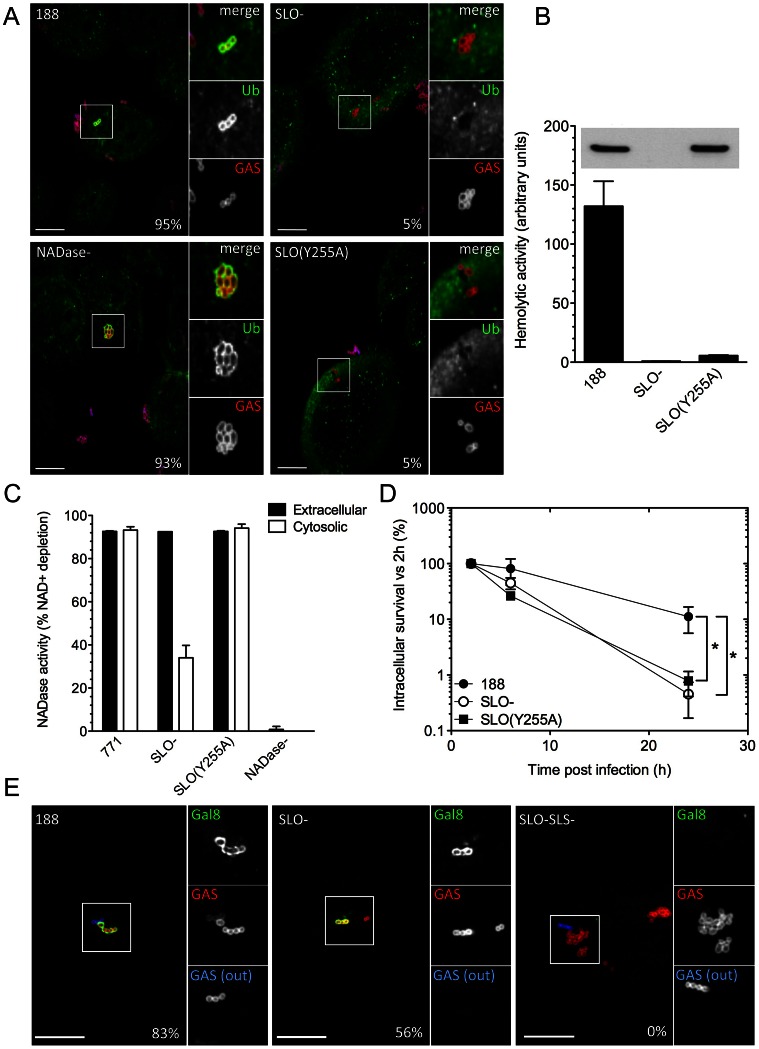
SLO, SLS, and NADase affect xenophagy and GAS intracellular survival.
A. Confocal microscopy demonstrating the association between ubiquitin (green) and intracellular GAS (red) at 30 min post-infection in keratinocytes infected with GAS strain 188, 188SLO-, 188NADase-, or 188SLO(Y255A). Extracellular GAS were stained blue and red for identification as described in Figure 2. Scale bar = 10 µm. The percentage of intracellular GAS that were associated with ubiquitin is indicated for each strain, based on quantification of at least 100 bacteria in three independent experiments. B. Hemolytic activity of culture supernatants of GAS strain 188, 188SLO-, and 188SLO(Y255A). The amino acid substitution Y255A in SLO abrogates the ability of SLO to porate the host cell membrane, demonstrated by the failure of culture supernatants from 188SLO(Y255A) to lyse erythrocytes despite producing wild-type amounts of the variant SLO protein. Inset, corresponding Western blot for SLO in culture supernatants from these strains. C. NADase activity in cell culture supernatants and in the cytosol of keratinocytes infected with GAS strain 771, 771SLO-, 771SLO(Y255A), or 771NADase-. Intracellular NADase activity due to translocation by extracellular GAS was identical between 771 and 771SLO(Y255A), but reduced in 771SLO-. D. The intracellular survival of 188SLO(Y255A) was significantly lower than that of its parental strain, 188, and similar to that of 188SLO-. *, P<0.01. E. Confocal microscopy demonstrating the association between galectin 8 (green) and intracellular GAS (red) in keratinocytes infected for 30 min with GAS strain 188, 188SLO-, or 188 SLO-SLS-. Extracellular GAS (GAS(out)) were stained blue and red for identification as described in Figure 2. Scale bar = 10 µm. The percentage of intracellular GAS that were associated with galectin 8 is indicated for each strain, based on quantification of at least 100 bacteria in three independent experiments. 188SLO-SLS- was never associated with galectin 8 (0%).